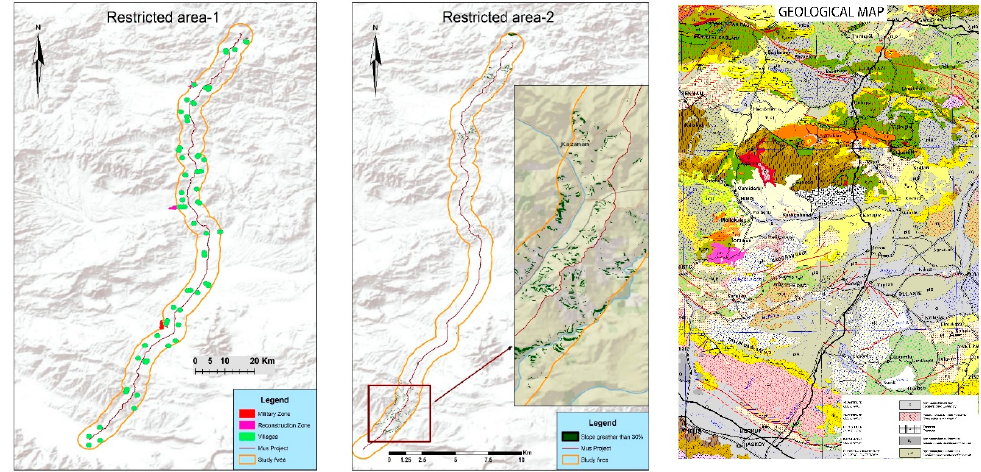
Figure 8. Spatial data layers.